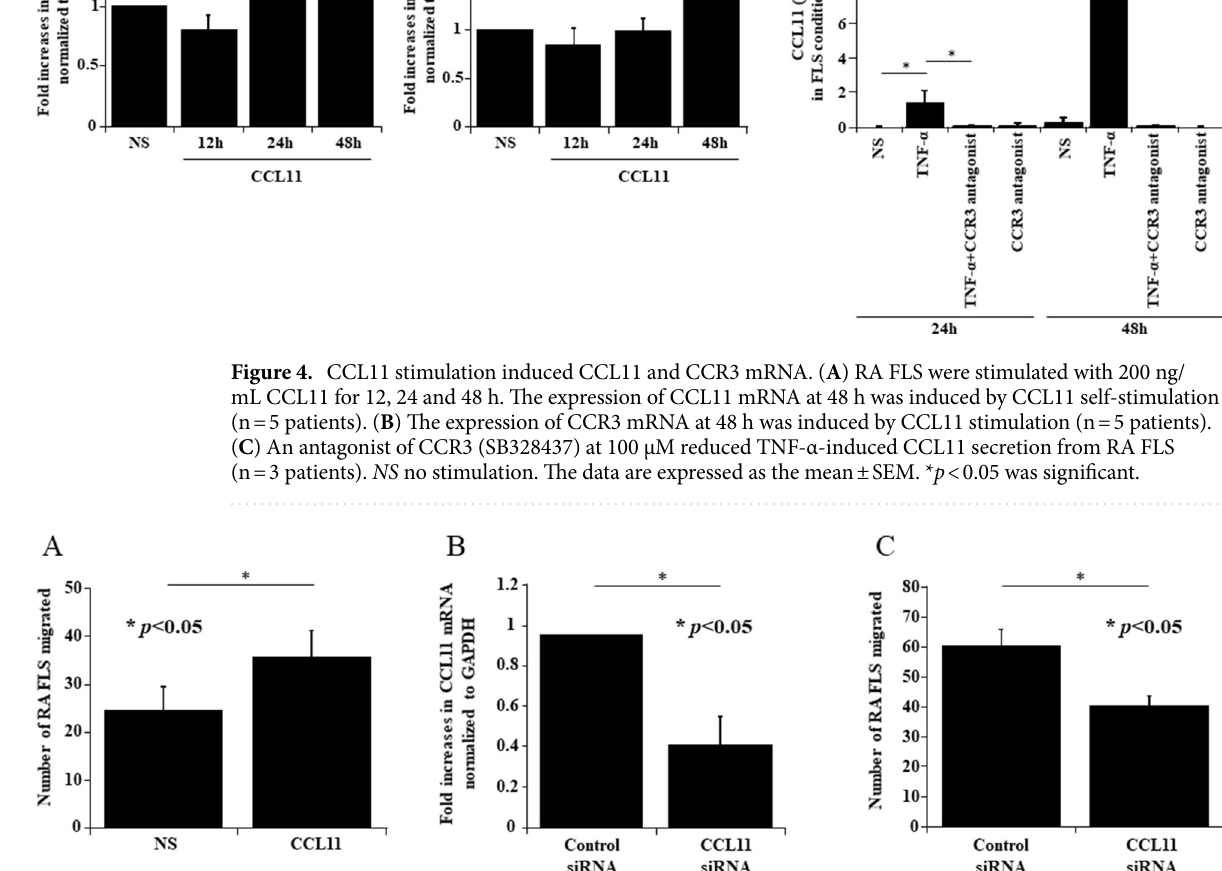
Figure 5. CCL11 induced the migration of RA FLS and THP-1 cells. ( A ) CCL11-stimulated RA FLS were significantly more efficient at migration than unstimulated FLS (n = 3 patients, 3 experiments each). ( B ) CCL11 siRNA treatment decreased the expression of CCL11 mRNA (n = 3 patients). ( C ) CCL11 siRNA treatment decreased the migration of RA FLS (n = 2 patients, 3 experiments each). NS no stimulation. The data are expressed as the mean ± SEM. * p < 0.05 was